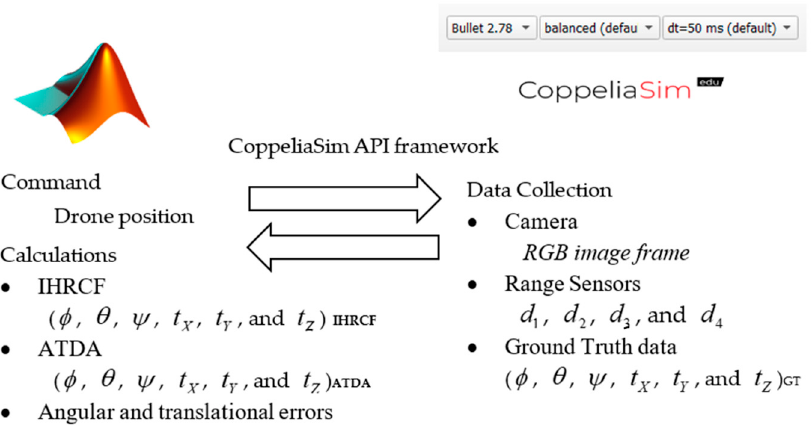
Figure 13. Software-in-the-Loop (SIL) data transmission and the connection protocol.